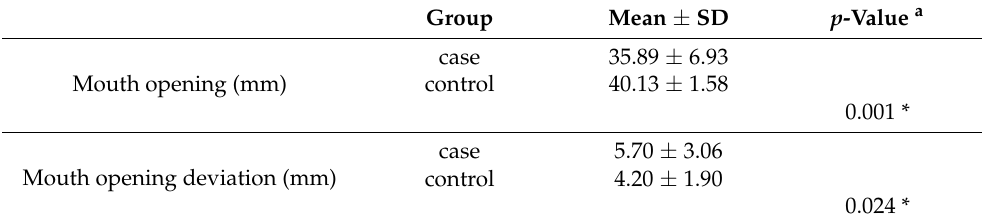
Table 5. Kinesiographic analysis (Mann–Whitney U test). Mean and standard deviation values of mouth opening and deviation on mouth opening calculated in millimeters (mm) in case and control groups. Group Mean ± SD p -Value a Mouth opening